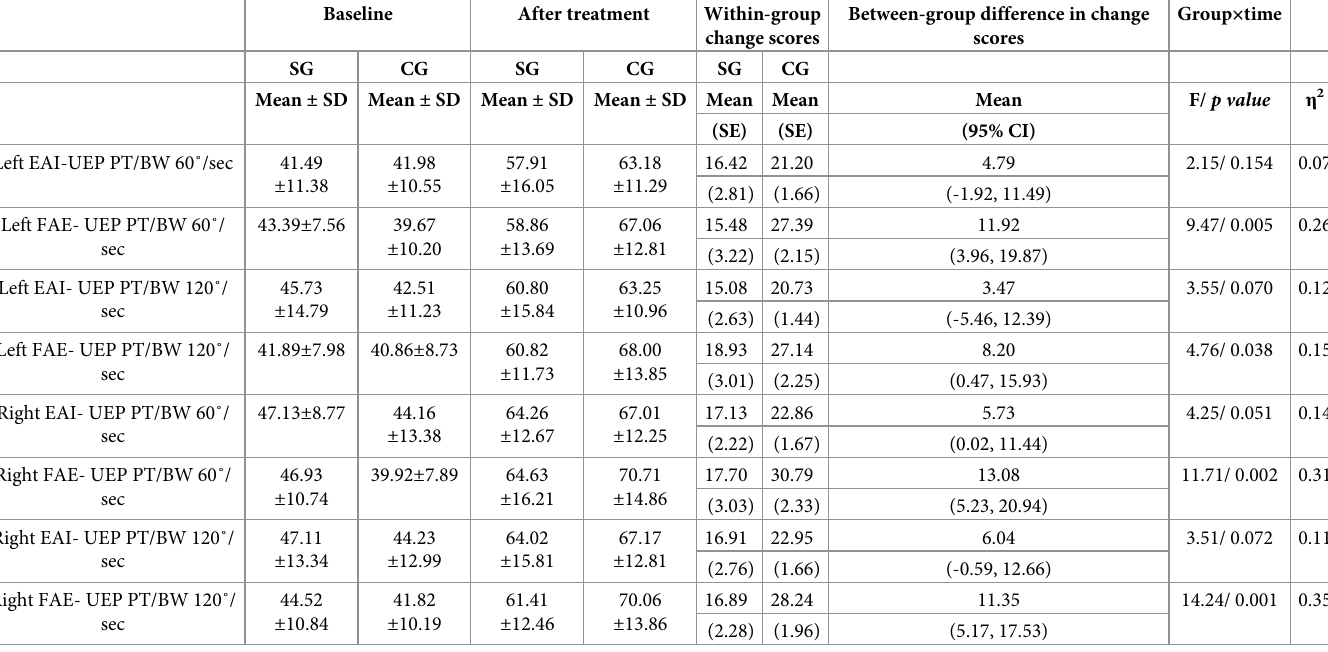
Table 3. Baseline, post-ıntervention and change scores for the EAI and FAE upper extremity patterns’ muscle strengths. Baseline After treatment Within-group